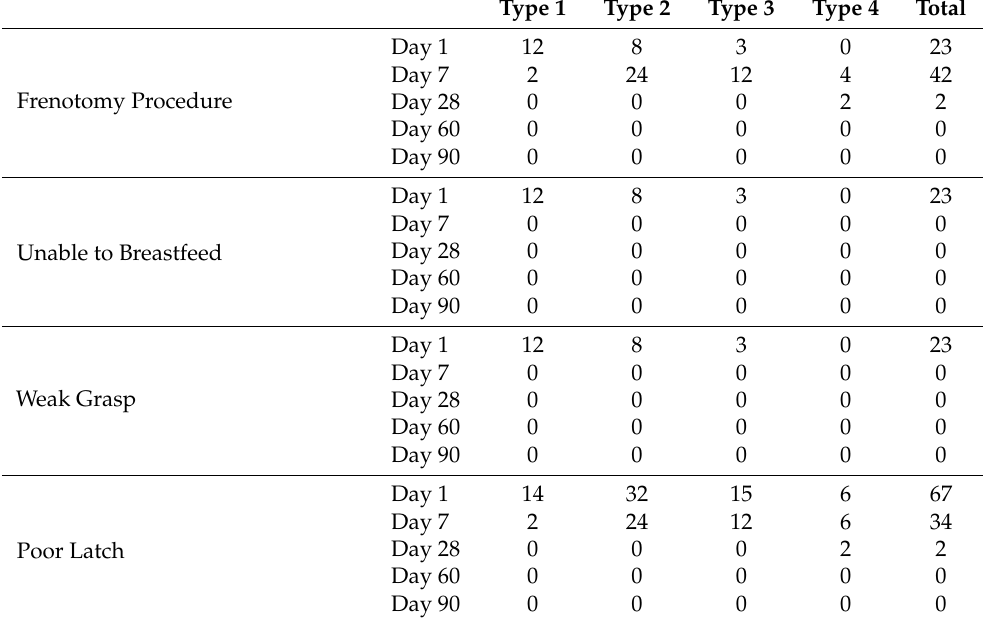
Table 3. Nutritional characteristics ( n =